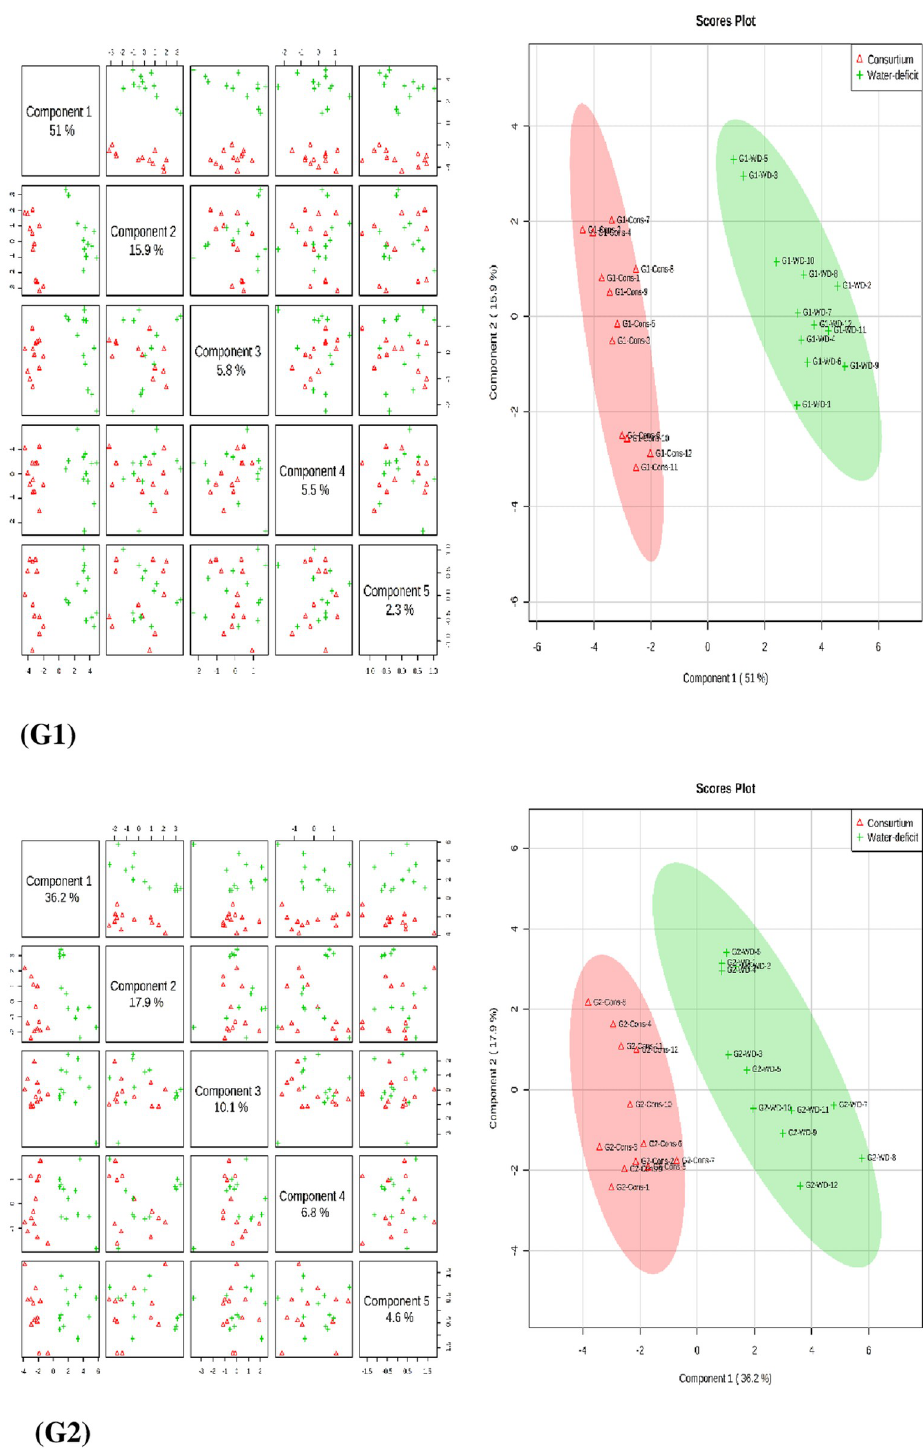
Fig 1. Partial least square discriminant analysis (PLS-DA) and 2D Scores loading plot for the chickpea Punjab Noor-2009 (G1) and 93127 (G2) leaves at 2 time points under consortium and water deficit treatments. Metabolites at consortium and drought treatments did not overlap indicating an altered state of metabolite levels in the chickpea leaves. Sampling time points are thereby demonstrating its effect over time and proofing in the leaves of chickpea